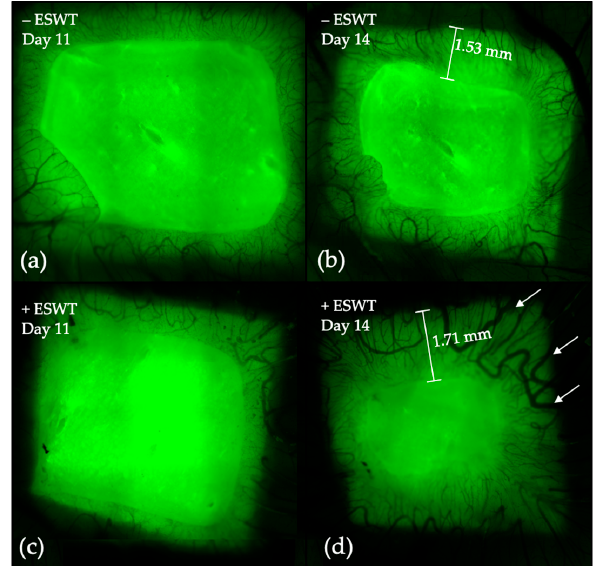
Figure 1. Exemplary multiple image arrays of treated and untreated specimens. ( a ) Intravital fluorescence image of the CM at EDD-11 in an egg of the control group. ( b ) Development of the vasculature up until EDD-14 in the control group. Vessels were growing into the transplant, forming a compact capillary network. ( c ) Twenty-four hours after therapy, the CM treated with ESWT showed a similar vascular density and vessel size compared to sham-treated one. ( d ) Within four days, the vascular network significantly increased. Compared to the sham-treated CM, the ESWT-treated specimen showed more and larger vessels (see arrows in ( d )) as well as a richer capillary network. The vasculature covered a greater proportion of the transplant. Abbreviations: CM—collagen matrix; ESWT—Extracorporeal shockwave